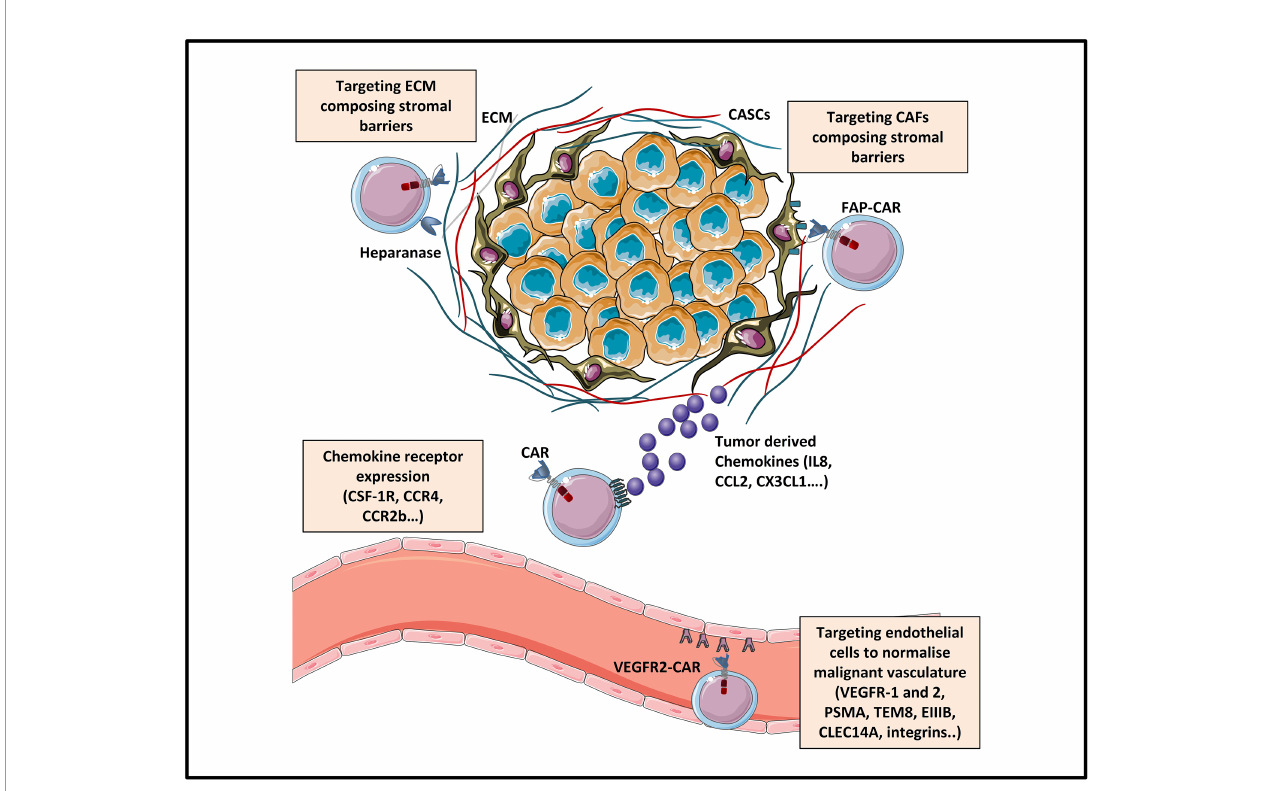
FIGURE 2 | Strategies enhancing tumor traf fi cking and penetration [Adapted from Ra fi q et al. (31)]. The traf fi cking of CAR-T cells towards tumor sites can be enhanced by engineering CAR-T cells expressing chemokine receptors (as for example CSF-1R, CCR4 or CCR2b) speci fi c for tumor-derived chemokine ligands (IL8, CCL2, CXCL1 … ). Tumor penetration of CAR-T cells can be enhanced by various strategies: (1) normalizing the malignant vasculature by targeting tumor blood vessels via CAR targeting of endothelial/tumoral antigens (like VEGFR, EIIIB, TEM8, integrins.), and (2) targeting physical barriers in the tumor microenvironment (TME) like the extracellular matrix (ECM) or the cancer associated fi broblasts